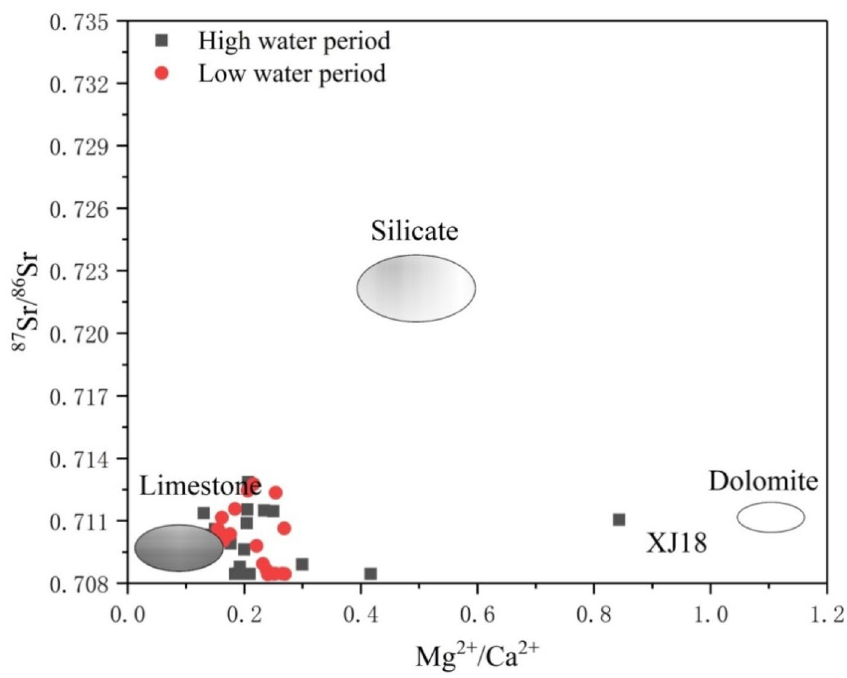
Figure 4. The relationship between the 87 Sr/ 86 Sr and Mg 2+ /Ca 2+ ratios in river water of the mainstream and tributaries. The oval fields represent the different end-members. If a sample point falls within one ellipse, then it is controlled by the corresponding end-member. If it falls between two or three ellipses, then it is controlled by both or all